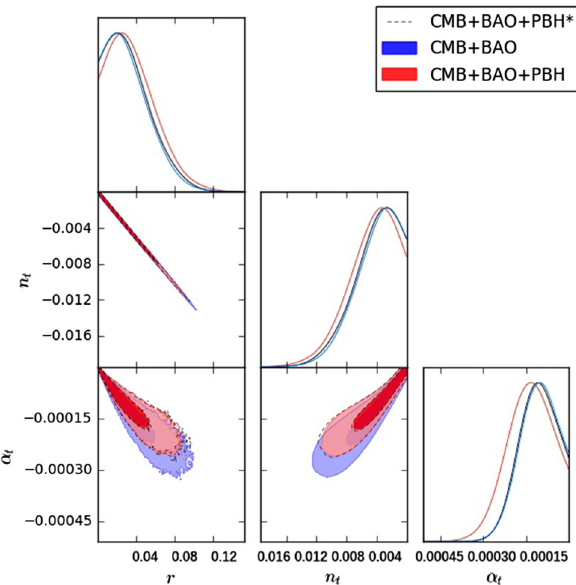
Fig. 3 The derived parameters r , n t and α t for the constrained canon- ical single-field slow-roll inflation model at the 68% and 95% CL from CMB + BAO + PBH*, CMB + BAO or CMB + BAO + PBH